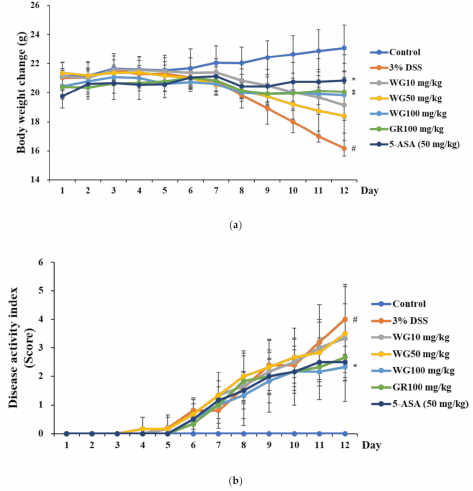
Figure 2. WG and GR extracts mitigate symptoms of dextran sulfate sodium (DSS)-induced colitis. Mice were divided into groups: control, 3% DSS-treated, 3% DSS-treated with WG and GR extracts (10, 50, or 100 mg/kg for WG and 100 mg/kg for GR), and 3% DSS-treated with 5-aminosalicylic acid (50 mg/kg). ( a ) Weight changes are given in grams (g). ( b ) Disease activity index (DAI) scores in the seven groups. Data are expressed as mean ± standard error of the mean (SEM) ( n = 6/treatment) (#: p < 0.05 vs. control; *: p < 0.05 vs. DSS